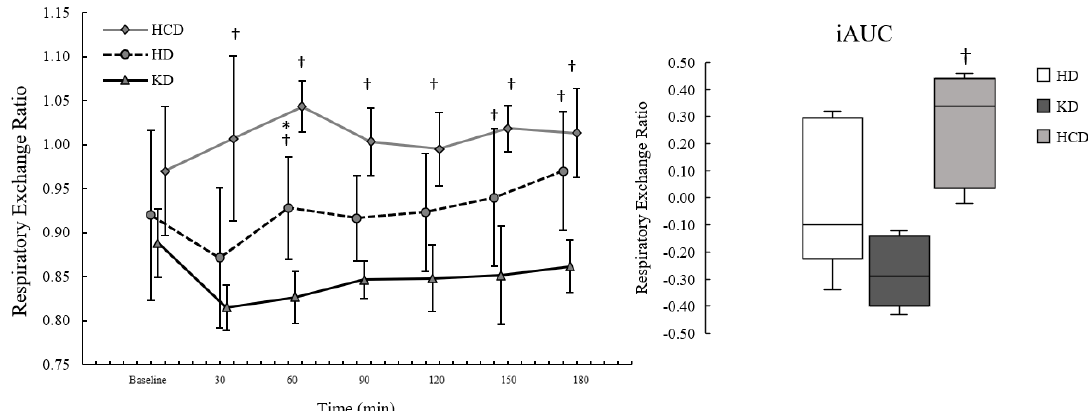
Figure 2. Postprandial respiratory exchange ratio (RER) following a ketogenic meal (KD), a high- carbohydrate meal (HCD), and a habitual meal (HD). Each point on the line graph is plotted as mean and standard deviation. The boxplots represent the incremental area under the curve (iAUC) where the line within each box represents the 50th percentile; the upper and lower limits of each box represent the 25th and 75th percentile; and the upper and lower error bars representing the 10th and 90th percentile. RER was significantly lower at all timepoints following the KD meal compared to the HCD meal (all p < 0.050) and at 60 min ( p = 0.034), 150 min ( p = 0.038), and 180 min ( p = 0.017) compared to the HD meal . Postprandial RER was significantly higher following the HCD meal compared to the HCD meal at 60 min ( p = 0.024). RER iAUC was significantly lower following the KD meal compared to the HCD meal ( p = 0.038). HD: habitual diet meal; KD: ketogenic diet meal; HCD: high-carbohydrate meal. † = significantly different from the KD at p ≤ 0.050. * = significantly different from the HCD at p ≤ 0.050.